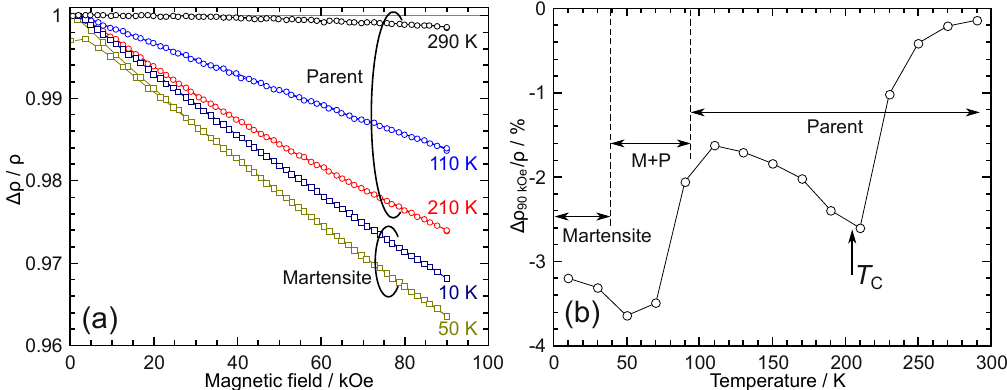
Figure 5. ( a ) Intrinsic magnetoresistance measured up to 90 kOe at 290, 210, 110, 50, and 10 K. ( b ) Intrinsic magnetoresistance under 90 kOe plotted against the measurement temperature. A peak is found near the Curie temperature of the parent phase, T C . The martensite phase generally shows a higher magnetoresistance than the parent phase.